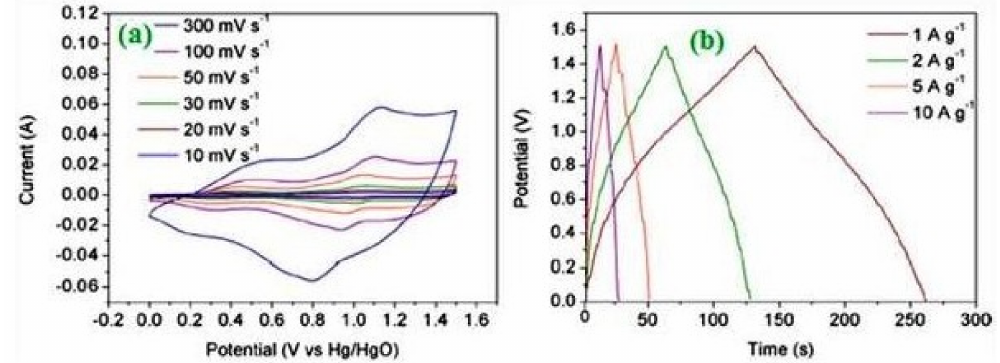
Figure 8. ( a ) The cyclic voltammetric curves in SC // AC ASC at di ff erent scanning rates ( b ) Galvanostatic charge / discharge curves at di ff erent current densities of the SC // AC ASC. Reprinted with permission from [97]. Copyright (2016), American Chemical